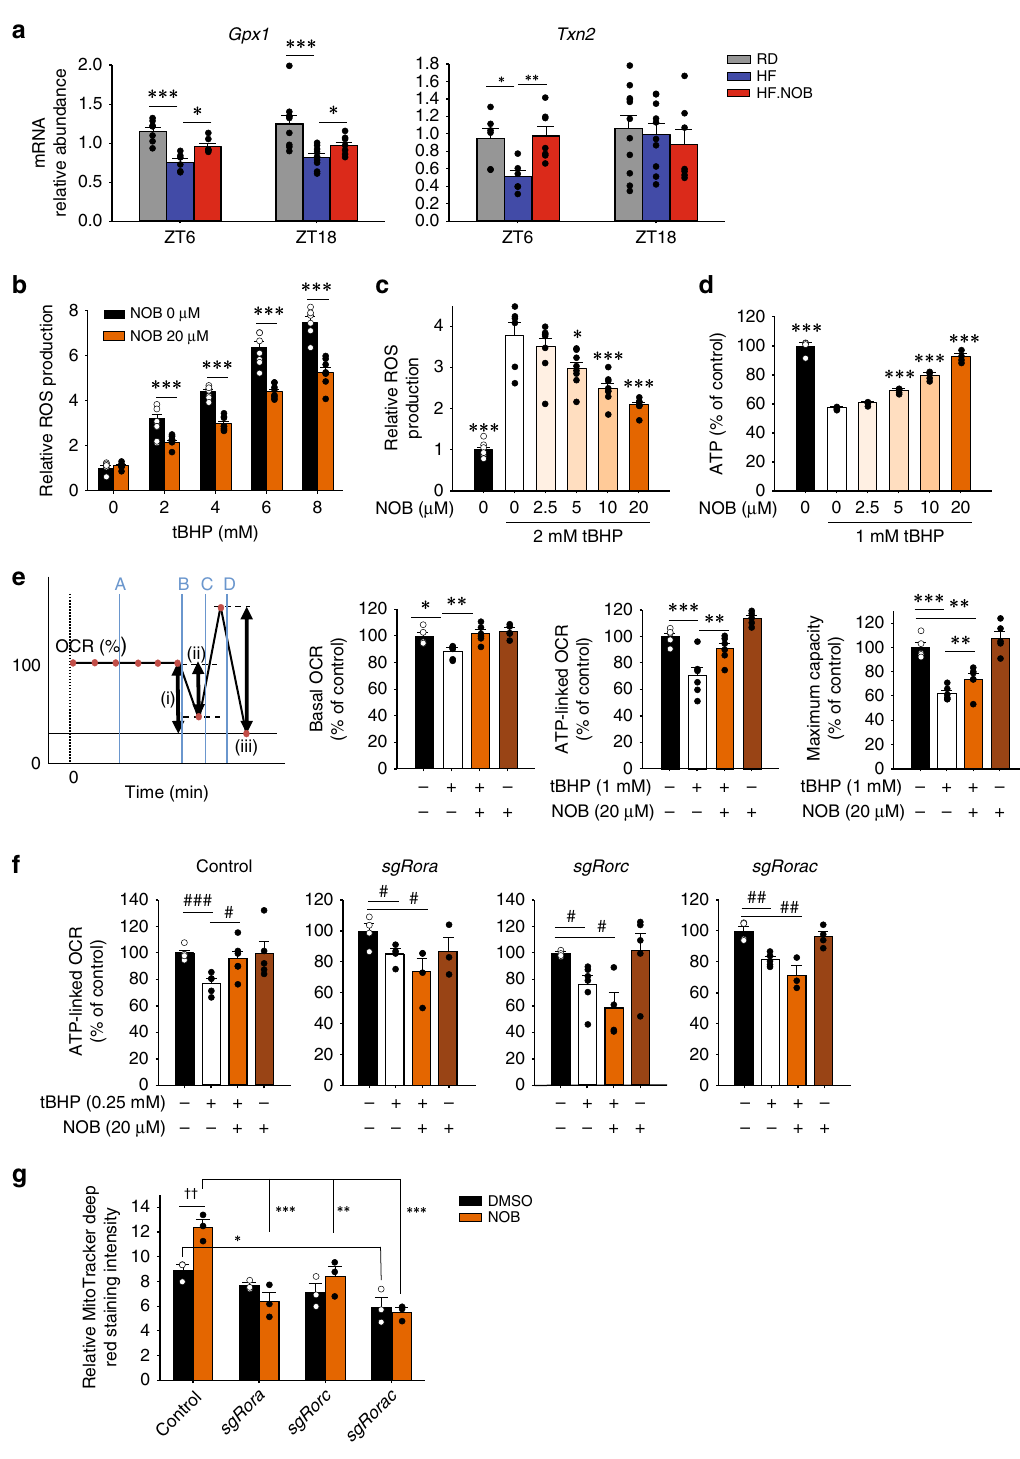
Fig. 5 NOB improved mitochondrial OXPHOS function. a Real-time qPCR analysis revealed enhanced expression of RORE-containing anti-oxidant genes in skeletal muscle from aged mice treated with NOB (ZT6, n = 7, 6, and 6 for RD, HF, and HF.NOB, respectively; ZT18, n = 9, 9, and 7 for RD, HF, and HF. NOB, respectively). b – g Effects of NOB in C2C12 cells. b , c NOB-suppressed tert-butyl hydroperoxide (tBHP) induced ROS production ( n = 6). d NOB rescued ATP production against tBHP-induced oxidative stress ( n = 4). e NOB restored mitochondrial OXPHOS function (PortA; Vehicle or 1 mM tBHP, PortB; 2.5 μ g/ml Oligomycin, PortC; 4 μ M FCCP, PortD; 2 μ M Antimycin A). Representative assay condition (line graph) and Basal OCR after tBHP treatment (left bar graph), ATP-linked OCR (middle bar graph), and maximum respiration capacity (right bar graph) ( n = 5) are shown. f NOB effect was attenuated by RORs knockdown ( n = 5). g MitoTracker deep red staining of control and ROR-deleted C2C12 cells ( n = 3). Two-way ANOVA analysis shows statistically signi fi cant differences between treatments and genotypes. * p < 0.05, ** p < 0.01, *** p < 0.001, one-way ANOVA; †† p < 0.01, two-way ANOVA; # p < 0.05, ## p < 0.01, ### p < 0.001, t -test. Data are presented as mean ± SEM in bar